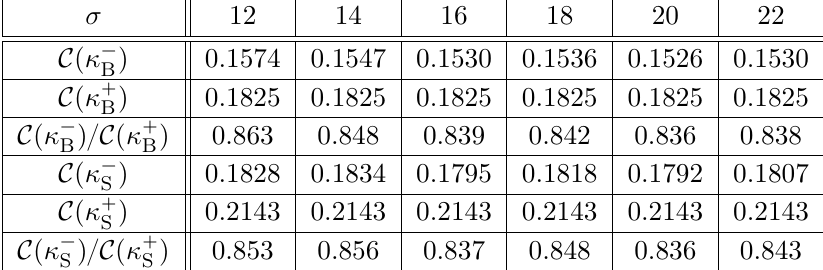
q and the ratios C p κ ´ i